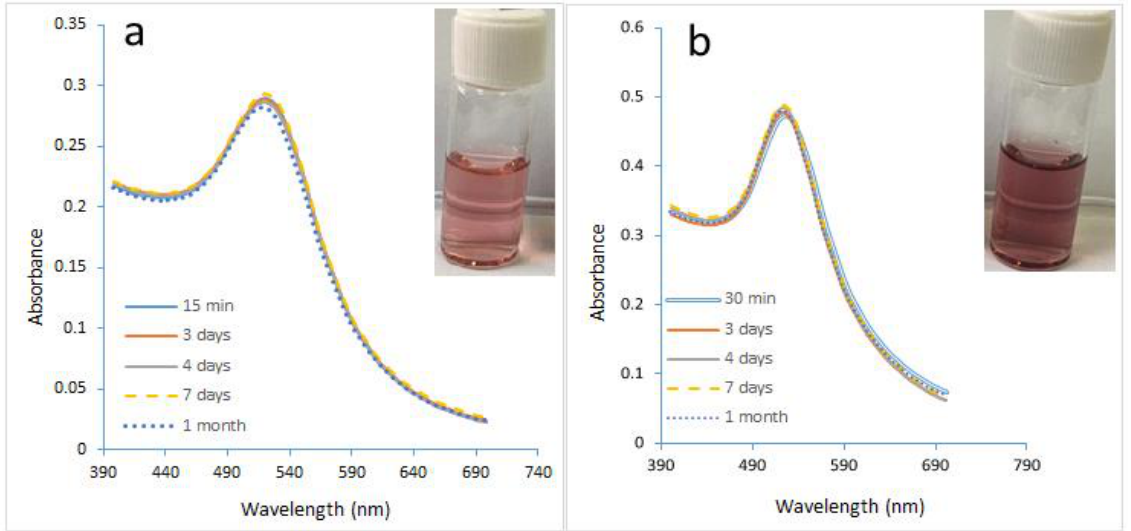
Figure 8. The UV spectra of GNPs samples prepared in the presence of PVA. ( a ) utilizing a microreactor, ( b ) batch method (Cons of HAuCl 4 = 0.7 mM, Cons of SC, SB = 0.1 mM T = 308.15 K, Volume ratio of SB/HAuCl 4 = 4:10, pH i = 3).